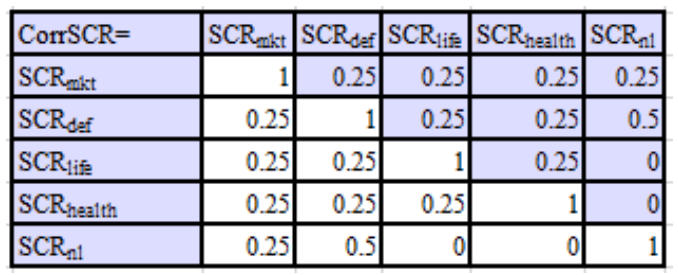
Fig. 1. Standard formula correlation matrix (EIOPA, 2014).